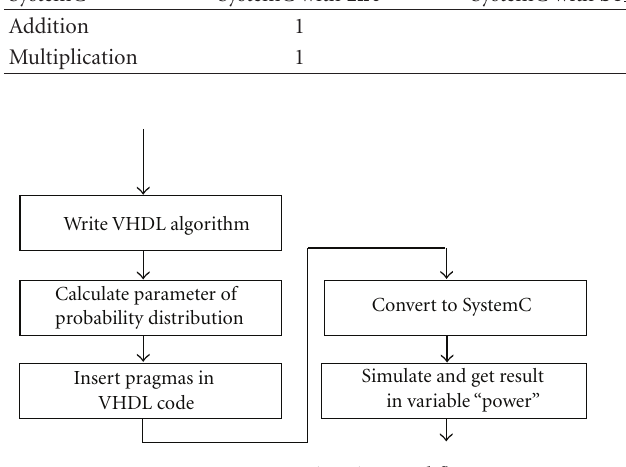
Figure 14: Power estimation